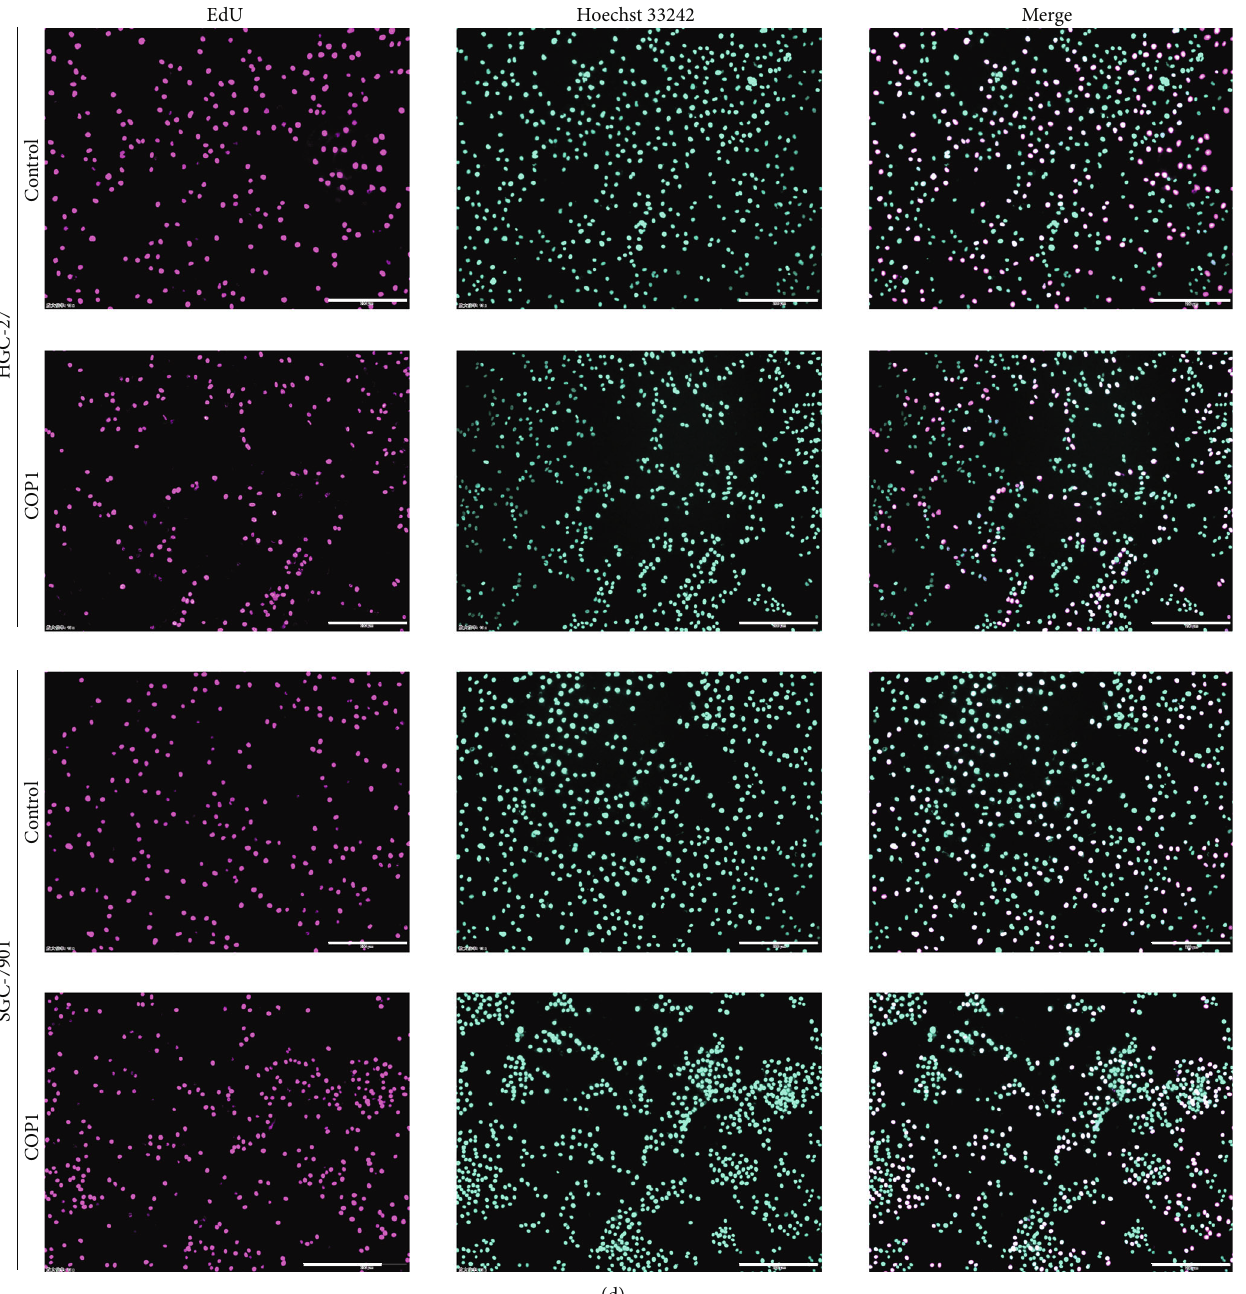
Figure 2: COP1 over-expression enhanced the vitality of GC cells. (a) COP1 over-expression signi fi cantly enhanced the vitality of GC cells; (b) WB assay veri fi ed the transfection e ffi ciency of GC cell lines; (c and d) COP1 over-expression signi fi cantly increased the numbers of EdU-positive GC cells. Bar=200 μ m. * P < 0 : 05 , ** P < 0 : 01 , *** P < 0 : 001